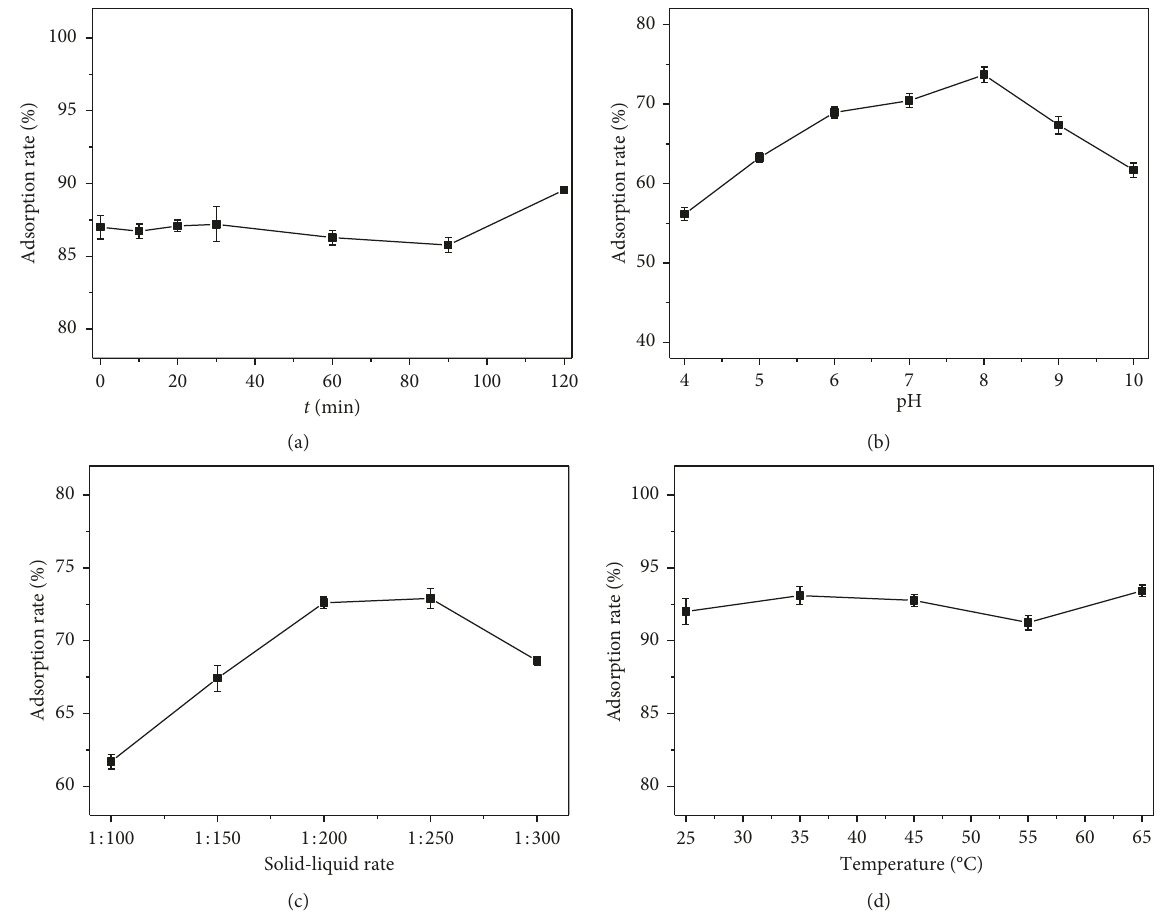
Figure 6: Effect of (a) adsorption time, (b) pH value, (c) solid-liquid ratio, and (d) adsorption temperature on the iodide